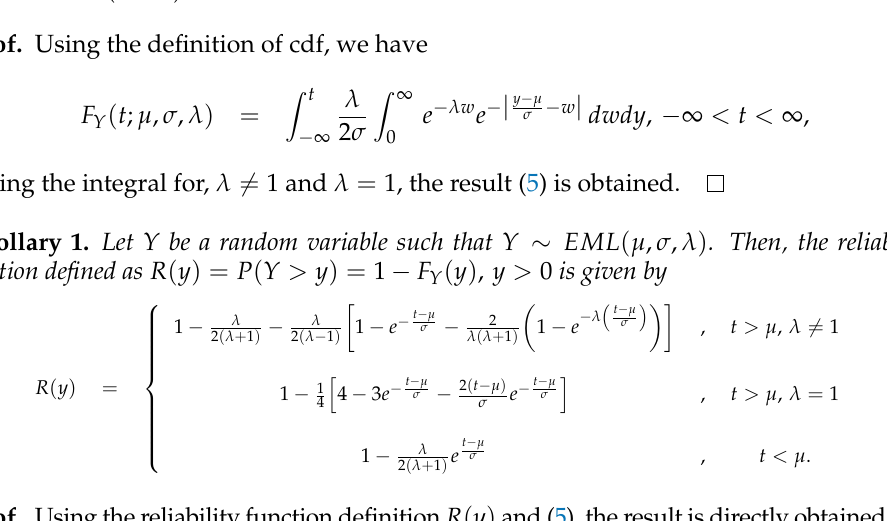
Figure 1. Graphical comparison of EML distributions with L for different values of λ ( upper ) and with ML and L ( lower